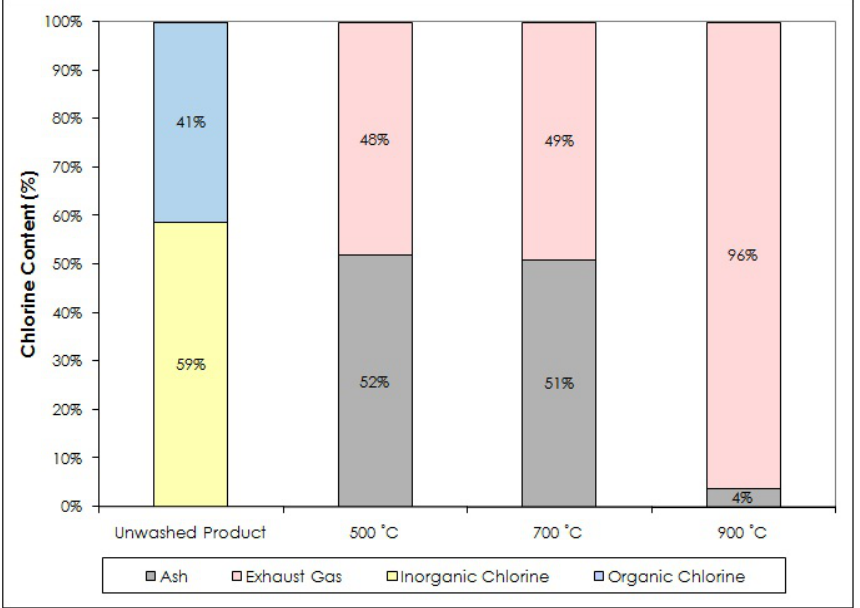
Figure 9. Chlorine contents after combustion of Unwashed Product with different combustion